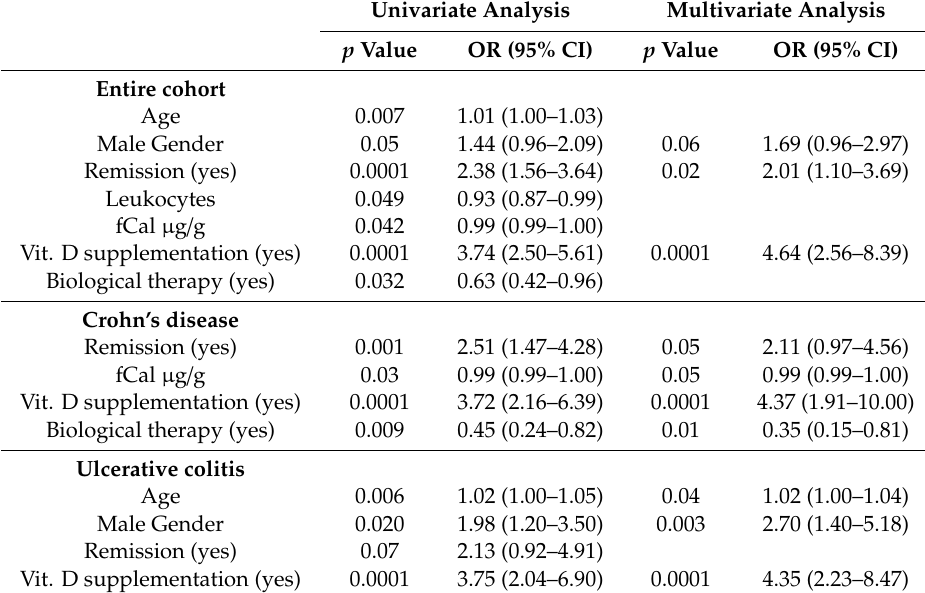
Table 4. Logistic regression analysis for factors associated with 25-hydroxyvitamin D (25(OH)D 3 ) serum levels ( < 30ng / mL) in Inflammatory Bowel Disease (IBD)